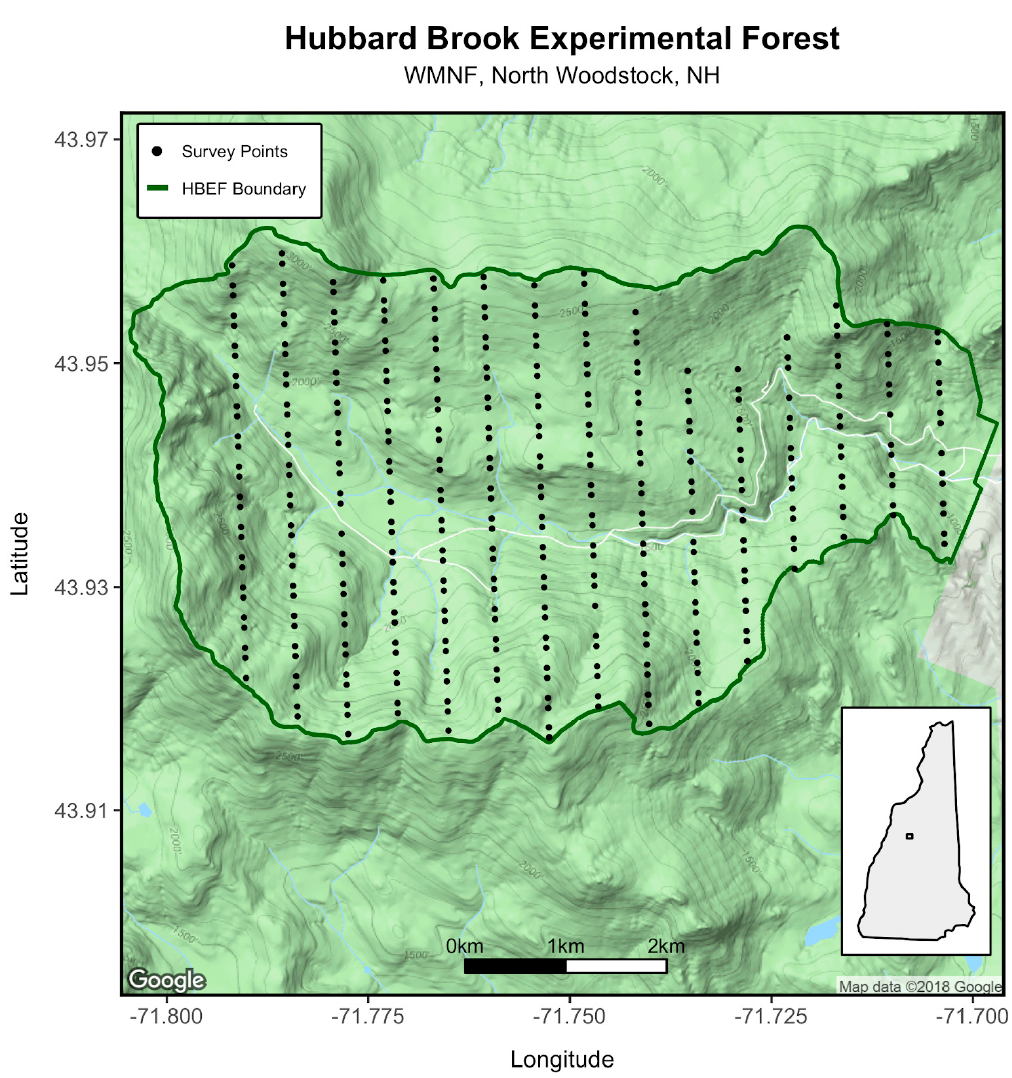
Figure 1. Map of Hubbard Brook Experimental Forest (HBEF) with survey locations in relation to New Hampshire.